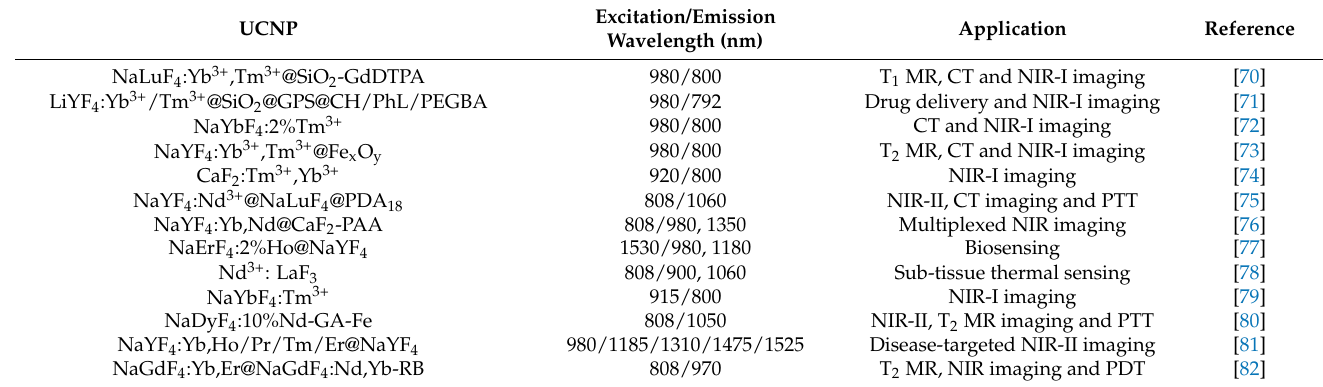
Table 2. Some examples of UCNPs and their biomedicine applications along with excitation and emission wavelengths. Excitation/Emission UCNP Application Wavelength (nm)